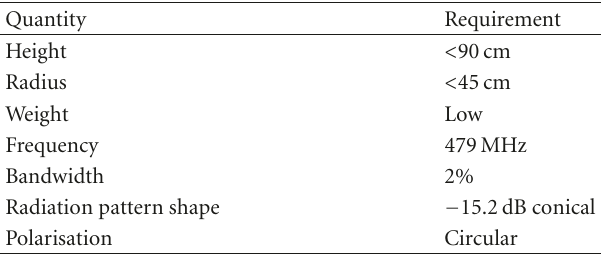
Table 1: Requirements for DTV broadcast